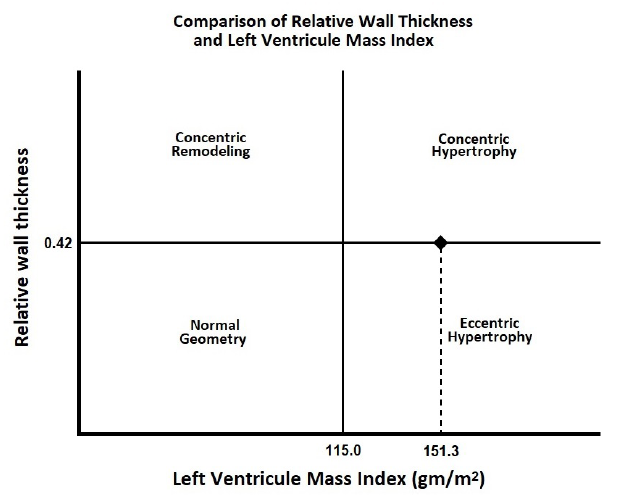
Figure 2. Relationship between relative wall thickness and left ventricle mass indexed by body surface area. The comparison per- mits categorization of an increase in LV mass as either concentric (relative wall thickness >= 0.42) or eccentric (relative wall thickness < 0.42) hypertrophy, according to Lang (2005) and Camarozano (2009). Our athlete (RC) is placed with 0.42 (relative wall thickness) and 151.5 gm/m2 (left ventricle mass